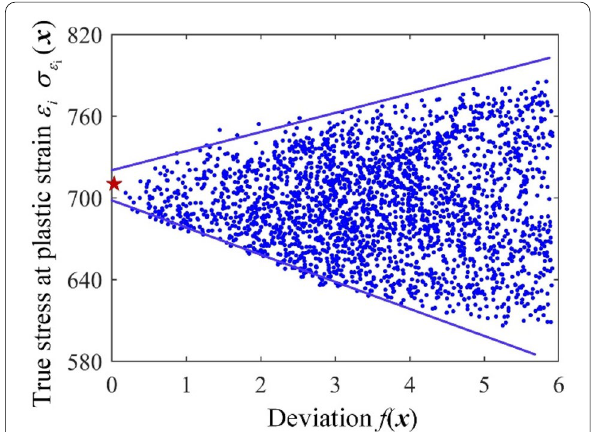
( x ) relationship indicating convergent i